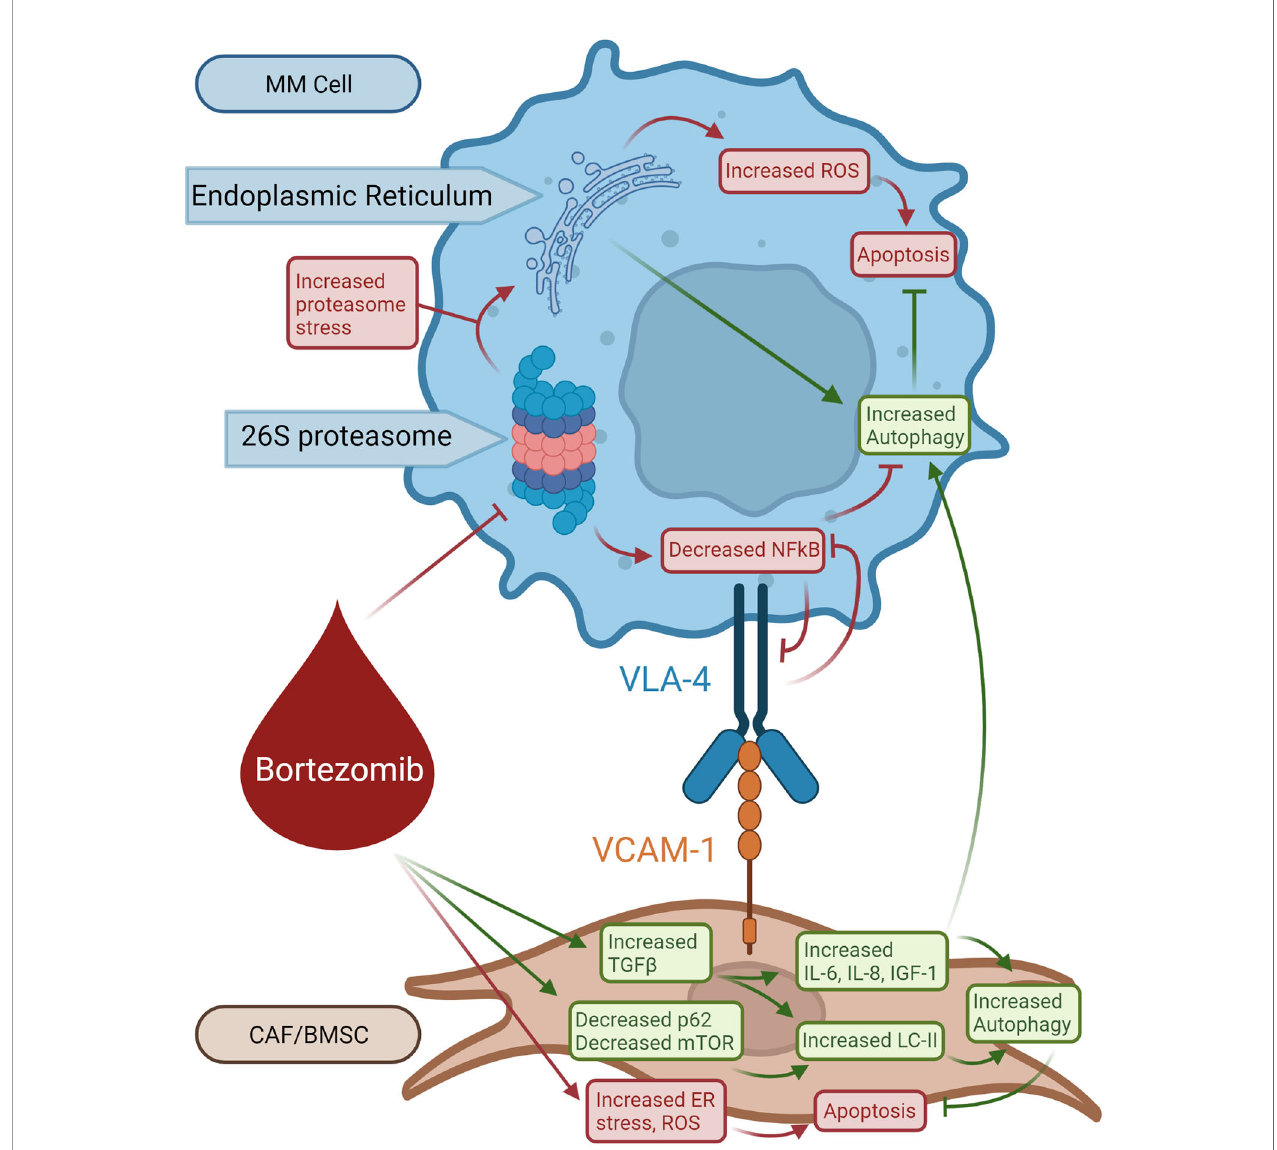
FIGURE 3 | Role of autophagy in bortezomib-induced resistant MM cells. Bortezomib inhibits 26S proteasome activity increasing proteasome stress and decreasing NFkB activity, resulting in decreased VLA-4 expression. Bortezomib also causes ER stress and production of ROS in BMSCs leading to apoptosis. Bortezomib selects for BMSCs that respond with increased TGF- b production. TGF- b increases LC-II, IL-6, IL-8, and IGF1 activity which opposes bortezomib-induced apoptosis and stimulates autophagy in BMSCs. BMSC-produced IL-6, IL-8, and IGF-1 from BMSCs promotes survival in MM